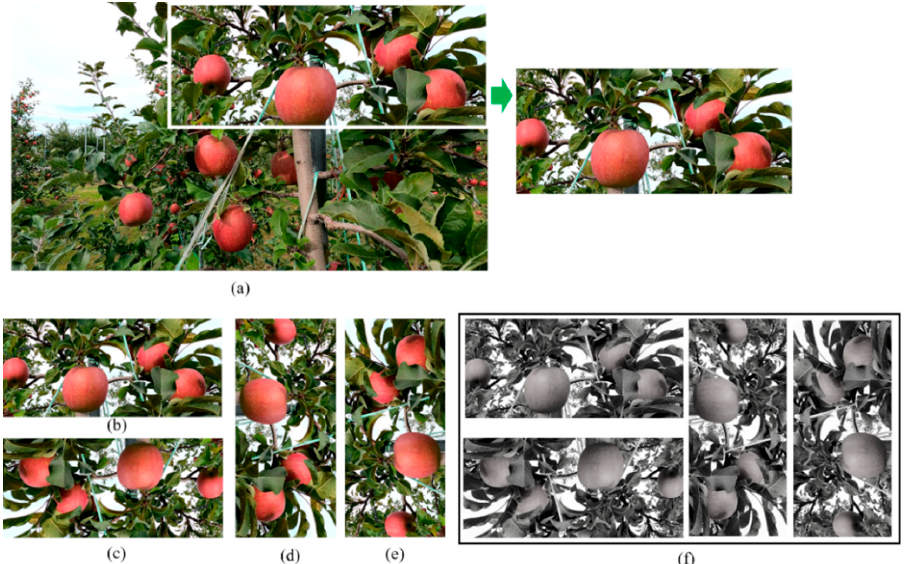
Figure 3. Dataset preparation and augmentation: ( a ) original RGB image, ( b ) cropped image from original image, ( c ) image rotated 180 ◦ , ( d ) image rotated 90 ◦ clockwise, ( e ) image rotated 90 ◦ counter- clockwise, and ( f ) all images when converted to grayscale.